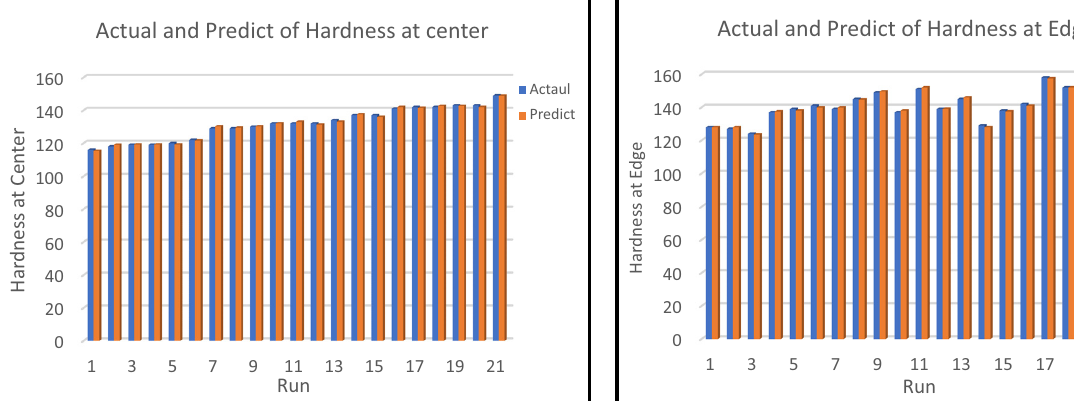
Figure 9: Predicted and actual value of H C and H E for